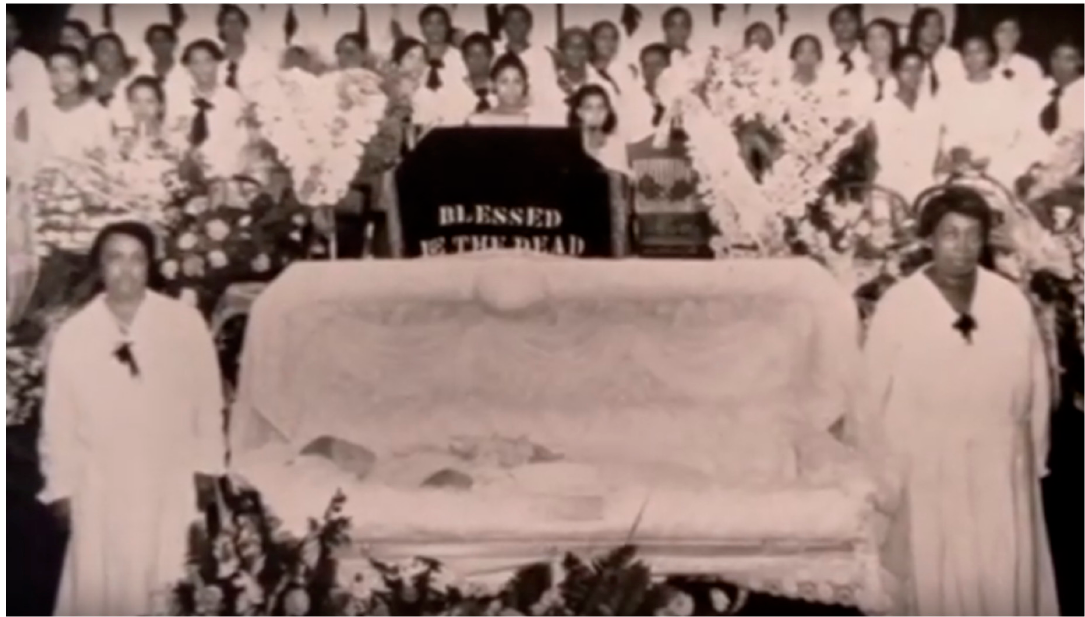
Figure 2. Nettie H. Dorsey and Thomas Dorsey Jr. still from Say Amen Somebody (1982).